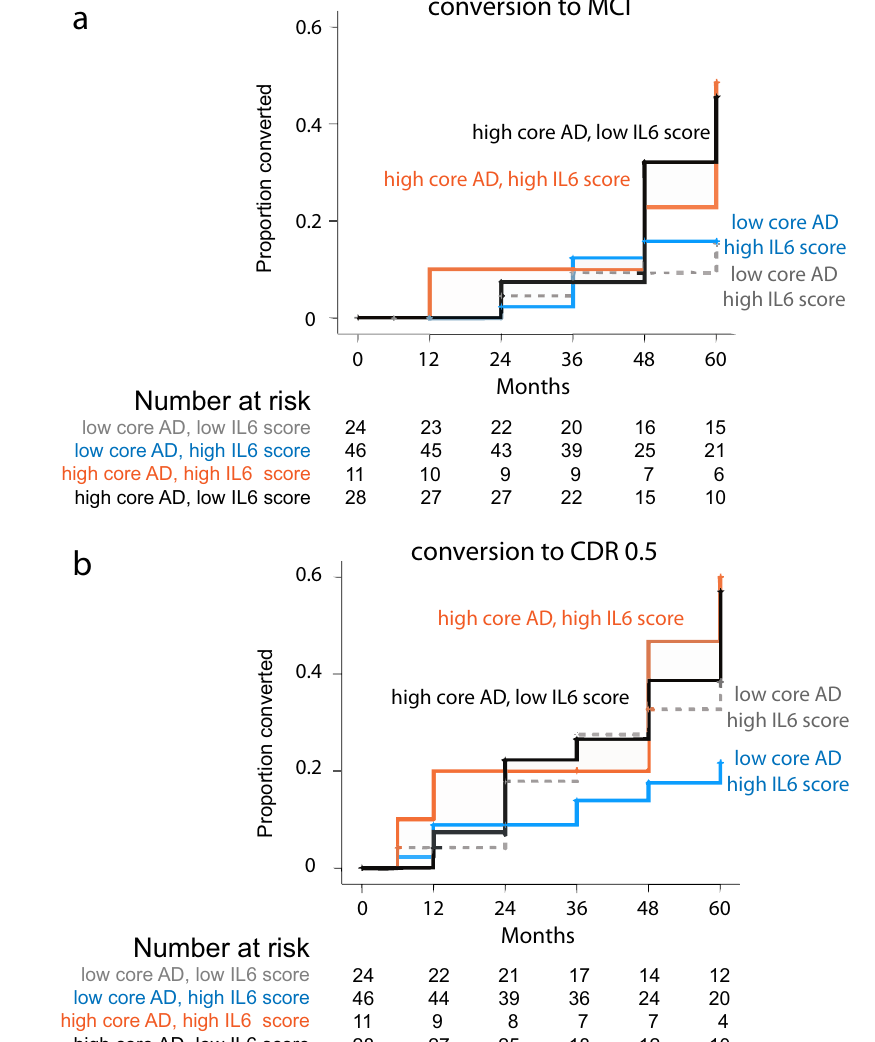
Fig. 3 Relationship between two protein family scores (core AD and IL6) and cognitive decline in participants with normal cognition (NC). NC participants with high core AD scores had earlier conversion to diagnosis of mild cognitive impairment (MCI; a , p = 0.021) or global clinical dementia rating score (CDR) of 0.5 ( b p = 0.023), but further strati fi cation according to IL6 score did not further re fi ne long-term cognitive outcomes. Sample size in the NC cohort was 109 after excluding two participants with very rapid decline from NC to dementia. Source data are provided as a Source Data fi